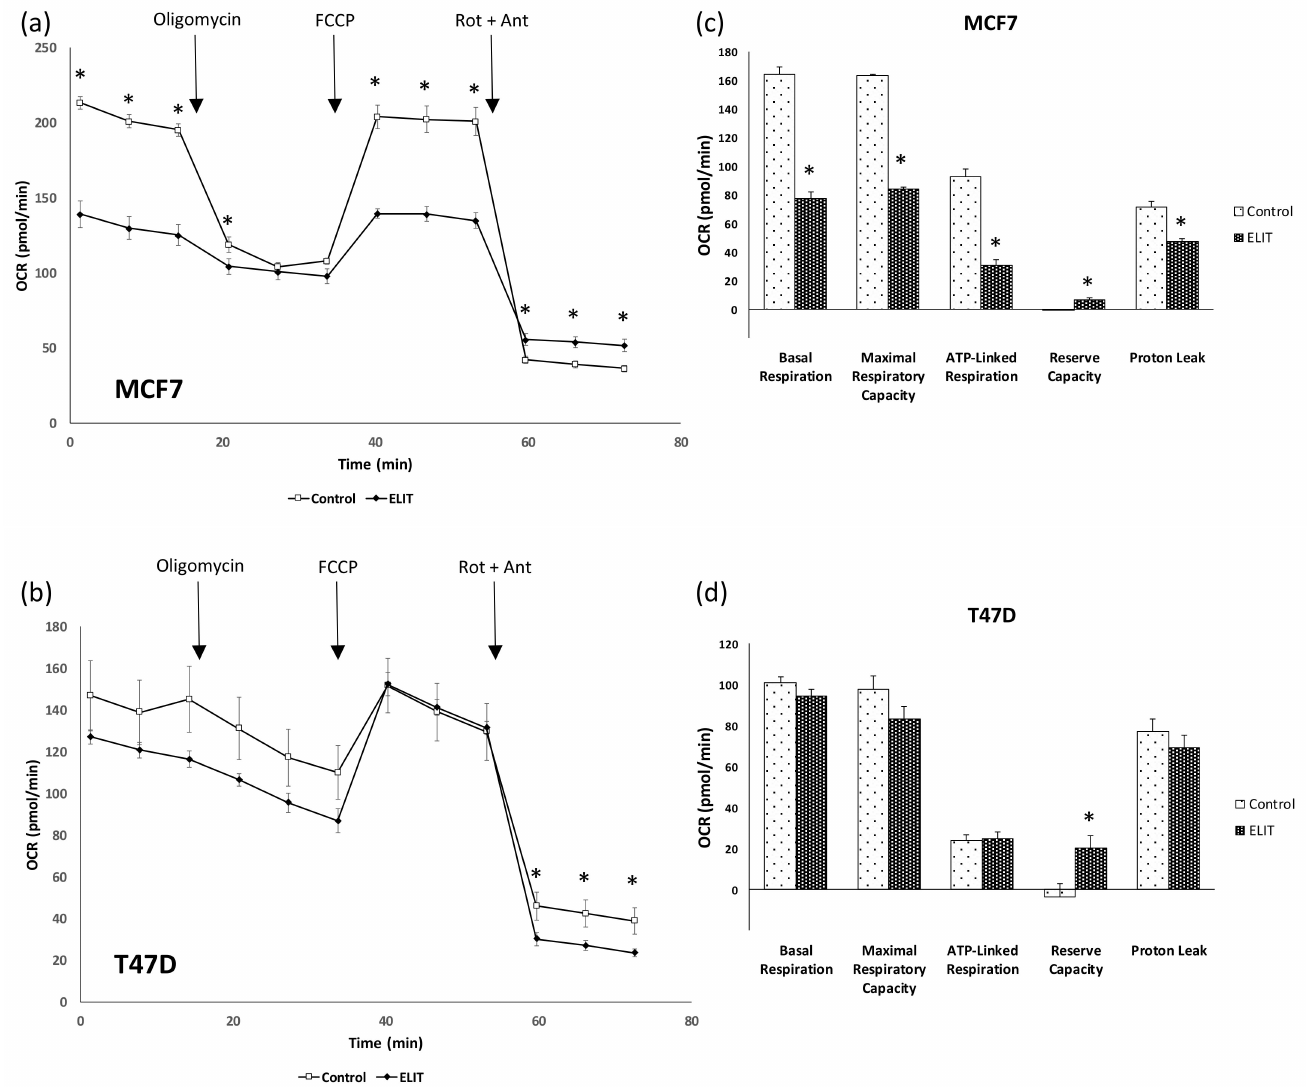
Figure 4. ELIT treatment reduced oxygen consumption ratio (OCR) in the MCF7 cell line. ( a , b ): OCR basal conditions and after oligomycin, FCCP, and antimycin A + rotenone addition. ( c , d ): calculated parameters from oxygen consumption analysis. Basal respiration: initial rate—antimycin A + rotenone rate; ATP-Linked Respiration: maximal respiratory capacity: FCCP rate—antimycin A+ rotenone rate; initial rate—oligomycin rate; Reserve capacity: FCCP rate—initial rate; proton leak: oligomycin rate—antimycin A+ rotenone rate. Values are expressed as means ± SEM ( n = 5). * Statistically significant difference between treated and vehicle-treated cells (Student’s t -test, p <